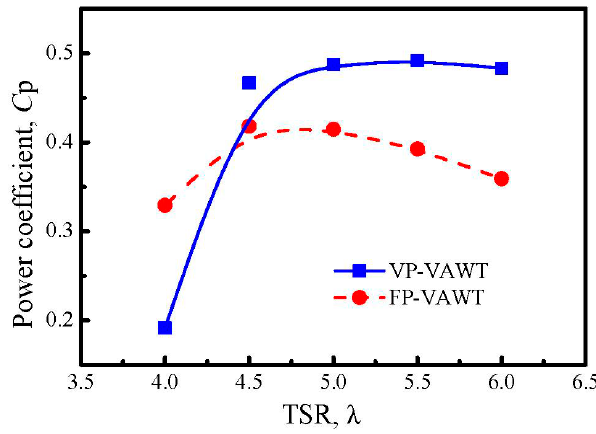
Figure 15. Power coefficient curves of VP-VAWTs and FP-VAWTs.